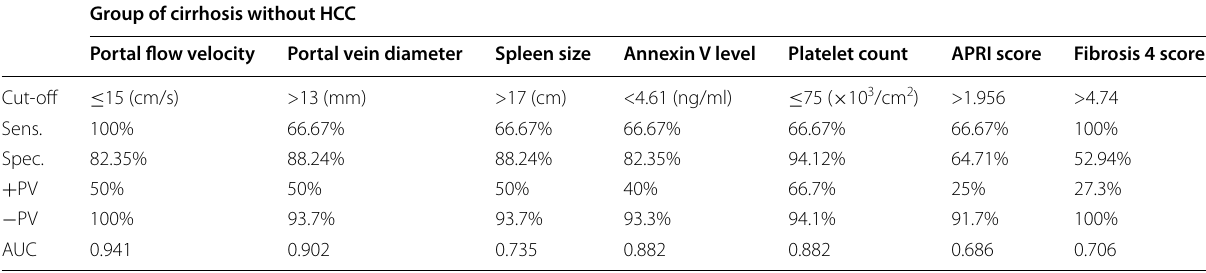
Table 2 Validity of portal flow velocity, portal vein diameter, spleen size, platelet count, Annexin V level, APRI score, and Fibrosis 4 score as PVT markers in cirrhotic patients without HCC